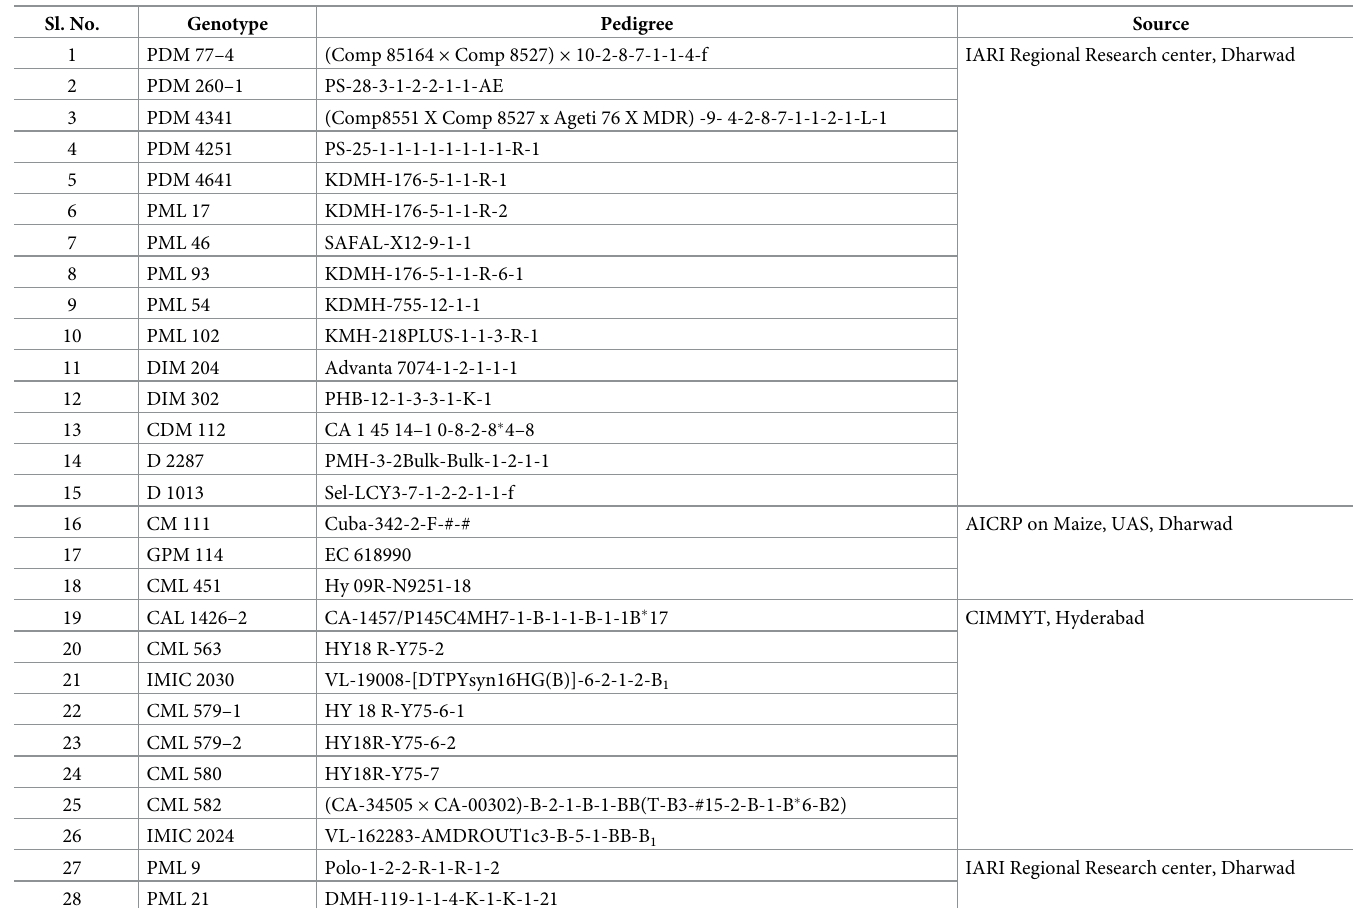
Table 1. List of corn genotypes with their pedigree and source. Sl. No.